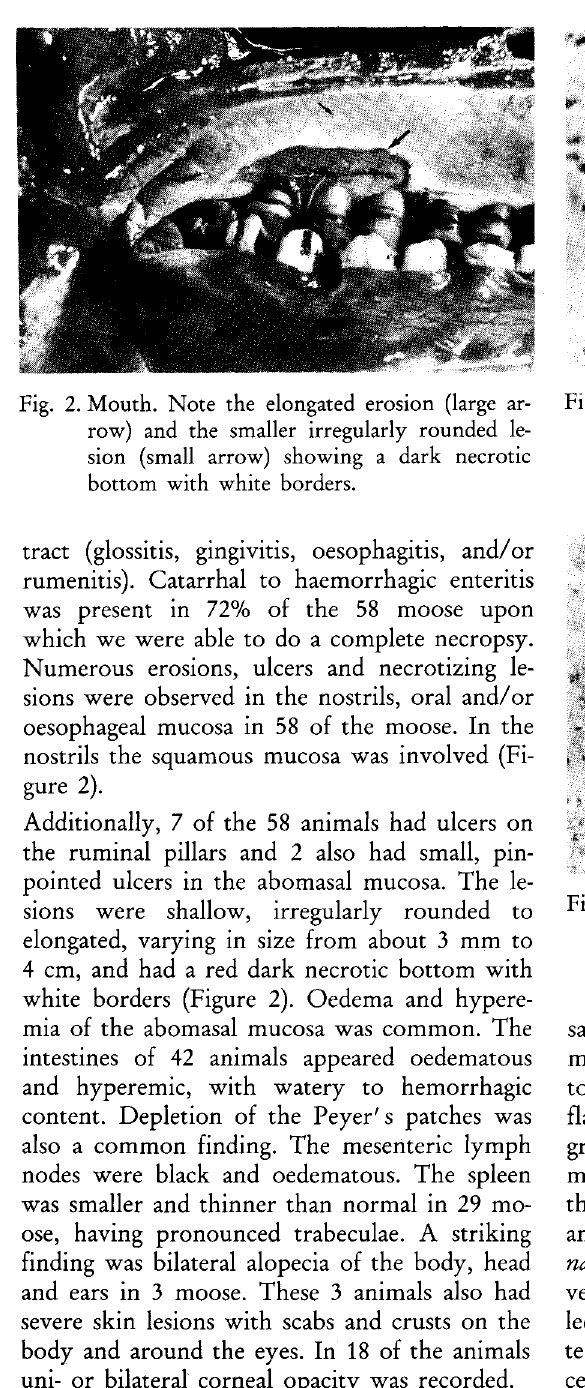
Fig. 3. Papillae bucalis. Note foci of swollen cells in stratum basale and spinosum (large arrows), and the inclusion bodies (small arrows). HEx400.